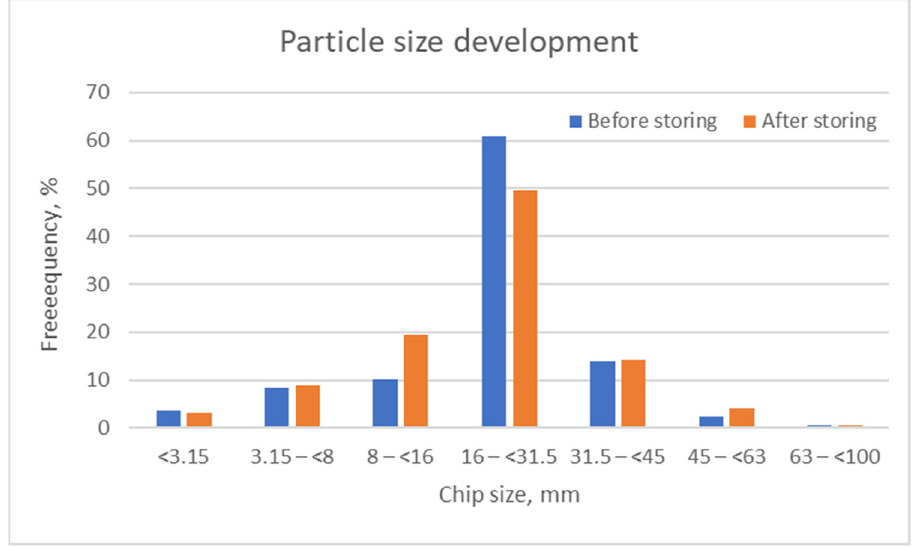
Figure 6. Particle size distribution in stemwood chip piles during the experiment before and after the storage period. storage